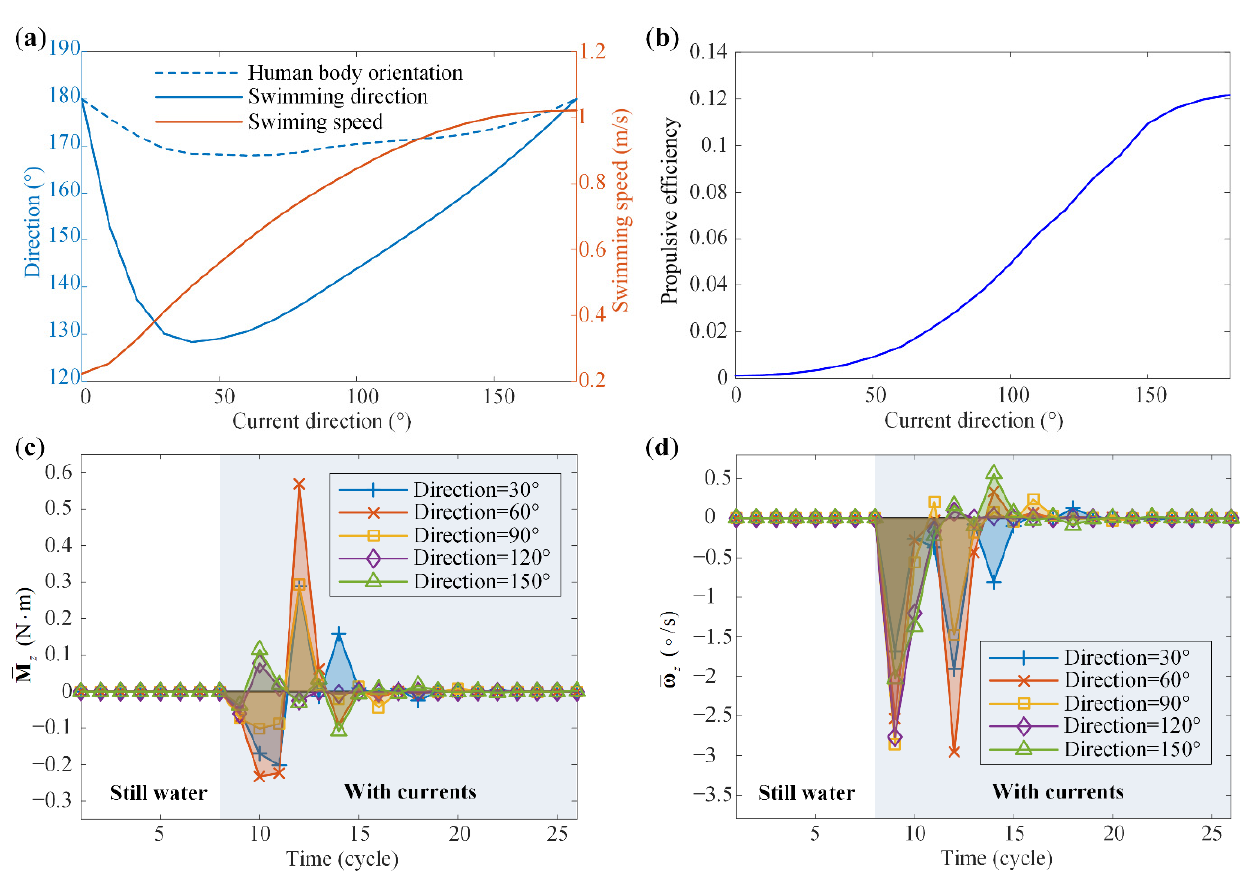
Figure 11. Analyses of the breaststroke swimming performance under the currents (velocity = 0.5 height/cycle) with variable direction (Case IV). ( a ) Evolution of the human body orientation, swimming direction, and swimming speed with respect to the current direction. ( b ) Evolution of the propulsive efficiency with respect to the current direction. ( c ) The average fluid moment per cycle applied to the human body about the global z axis ( M z ) at different current directions. ( d ) The average angular velocity of the human body per cycle about the z axis ( ω z ) at different current